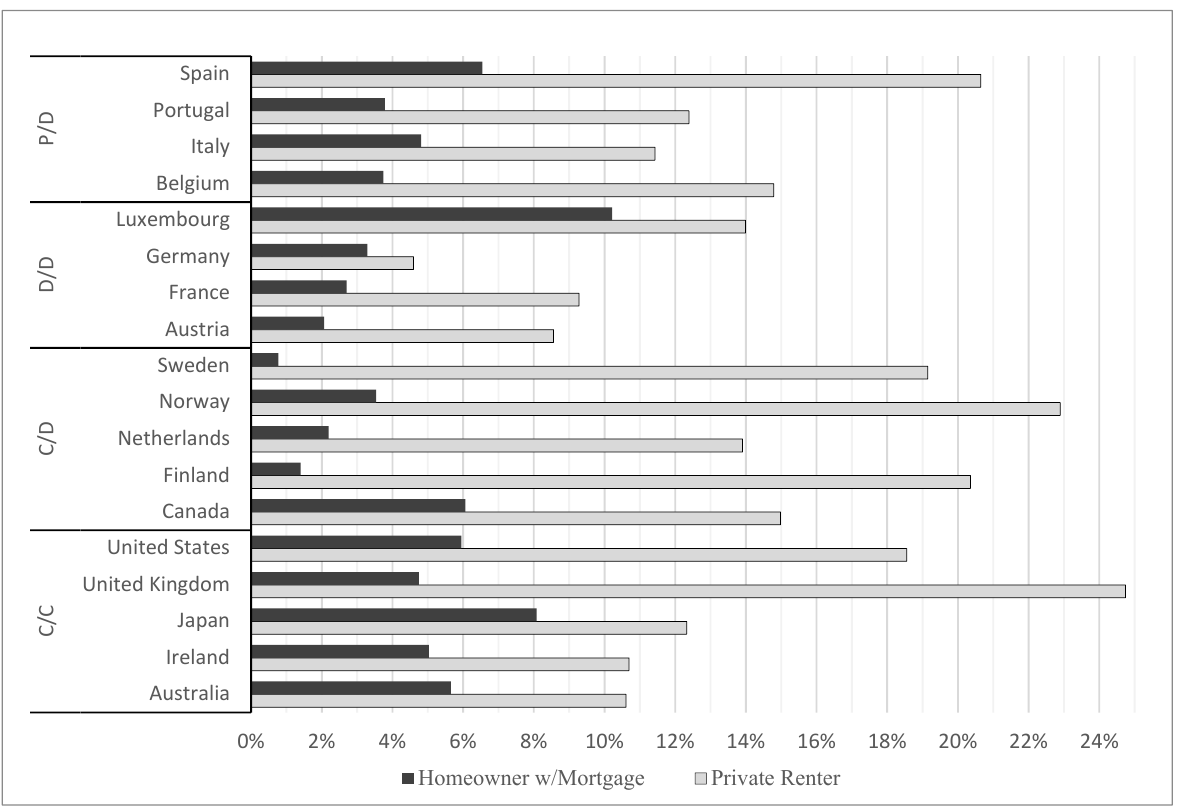
Figure 6. Share of population spending more than 40% of disposable income on mortgage and rent, by tenure—2019 or most recent year. Source: OECD Affordable Housing Database (2021a, 2021b).